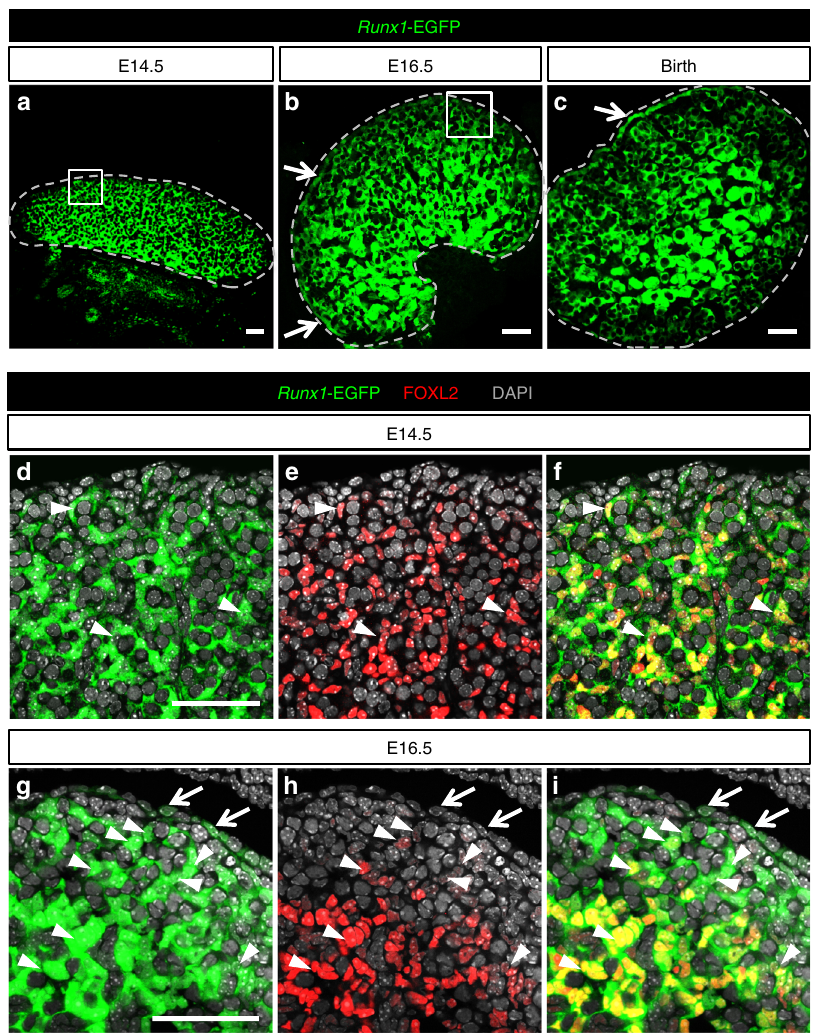
Fig. 3 Runx1 expression is maintained in pre-granulosa cells throughout fetal ovarian development. a – c Immuno fl uorescence for EGFP on Tg( Runx1 -EGFP) ovary sections at E14.5, E16.5, and birth. Scale bars: 50 µ m. d – i Immuno fl uorescence for EGFP and the pre-granulosa cell marker FOXL2 at E14.5 ( d – f ) and E16.5 ( g – i ), corresponding to the white square outlined areas in a and b , respectively. Runx1 is expressed in pre-granulosa cells throughout ovarian development and the surface epithelium after E14.5. Dotted lines outline the gonads. Arrows: EGFP + ovarian surface epithelium. Arrowheads: EGFP/ FOXL2 double-positive cells. Scale bars: 50 µ m. At least three independent biological replicates were analyzed and the images presented are representative of